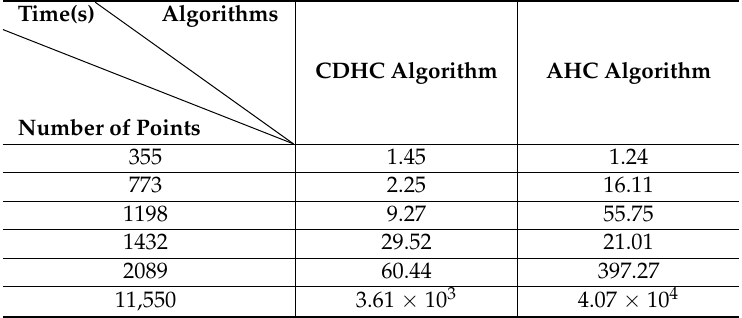
Table 1. A comparison of time complexity between CDHC and AHC algorithms.